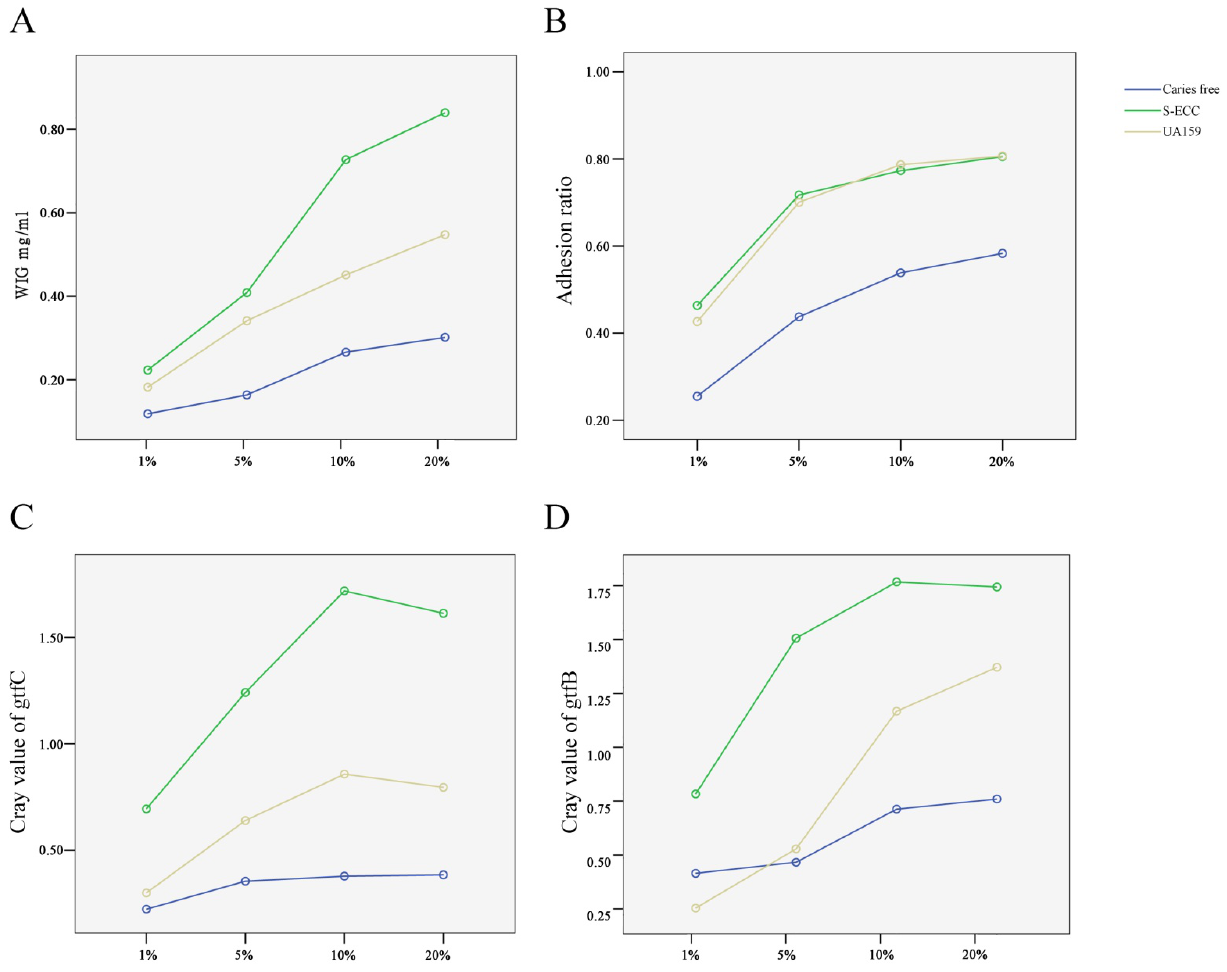
Figure 5. The capacity for sucrose-dependent adhesion of S. mutans from S-ECC and caries-free groups, with strain UA159 as control. The increase in WIG synthesis ( A ); adhesion ratio ( B ); and the expression of gtfC ( C ) and gtfB ( D ) was sucrose-concentration-dependent, especially the strains from the S-ECC and UA159